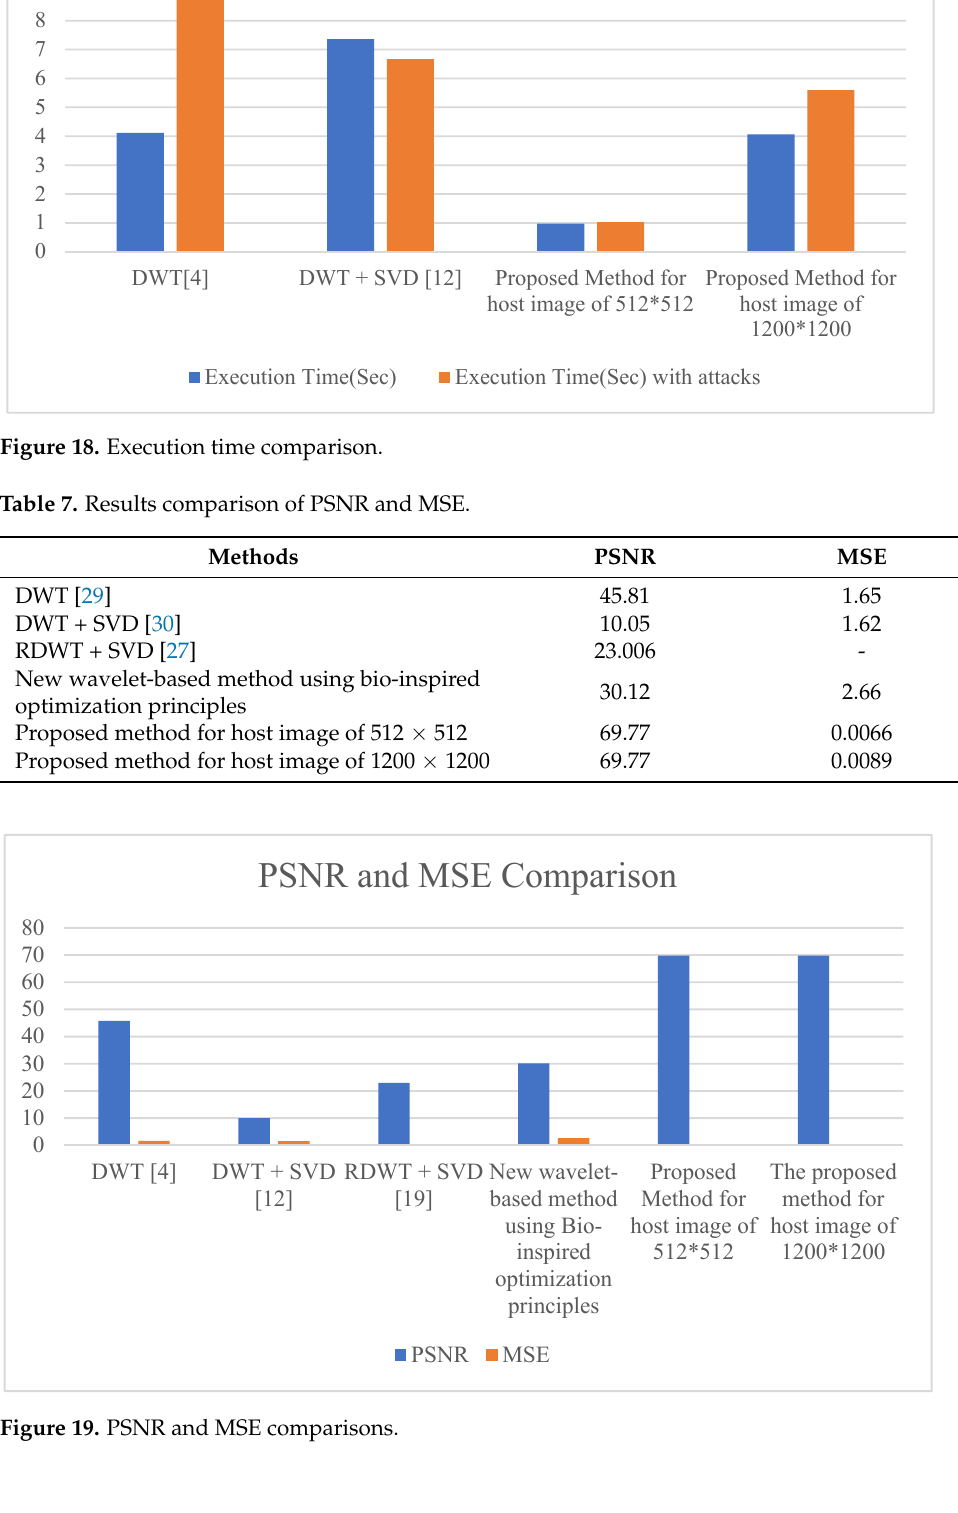
Table 8. Results comparison of NC for different types of attacks.